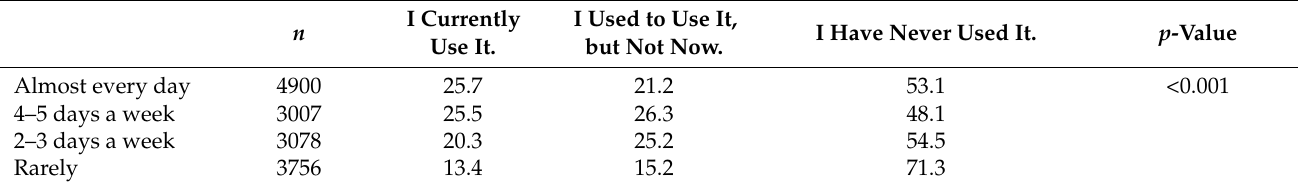
Table 5. The relationship between frequency of a well-balanced diet and prevalence of vitamin supplement usage.